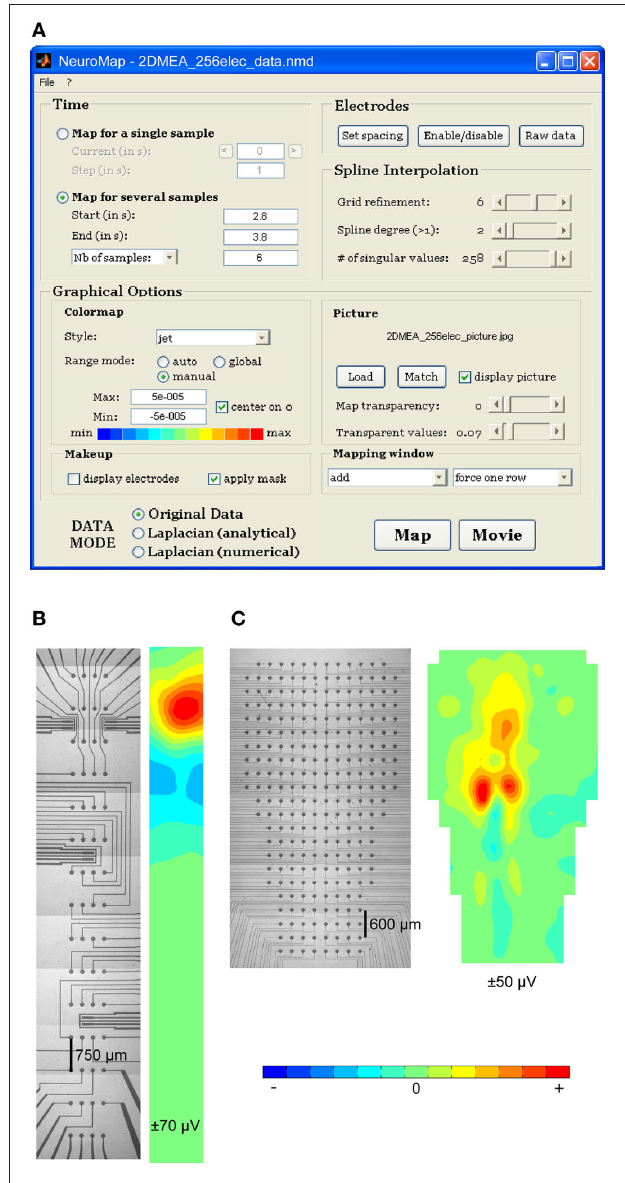
Figure 2 | NeuroMap interface and mapping of experimental data from 2D MeAs. (A) NeuroMap interface for plane MEA-recorded data. (B) An example of rectangular 60-channel MEA (left) and corresponding map (right). (C) An example of irregularly shaped 256-channel MEA (left) and corresponding map